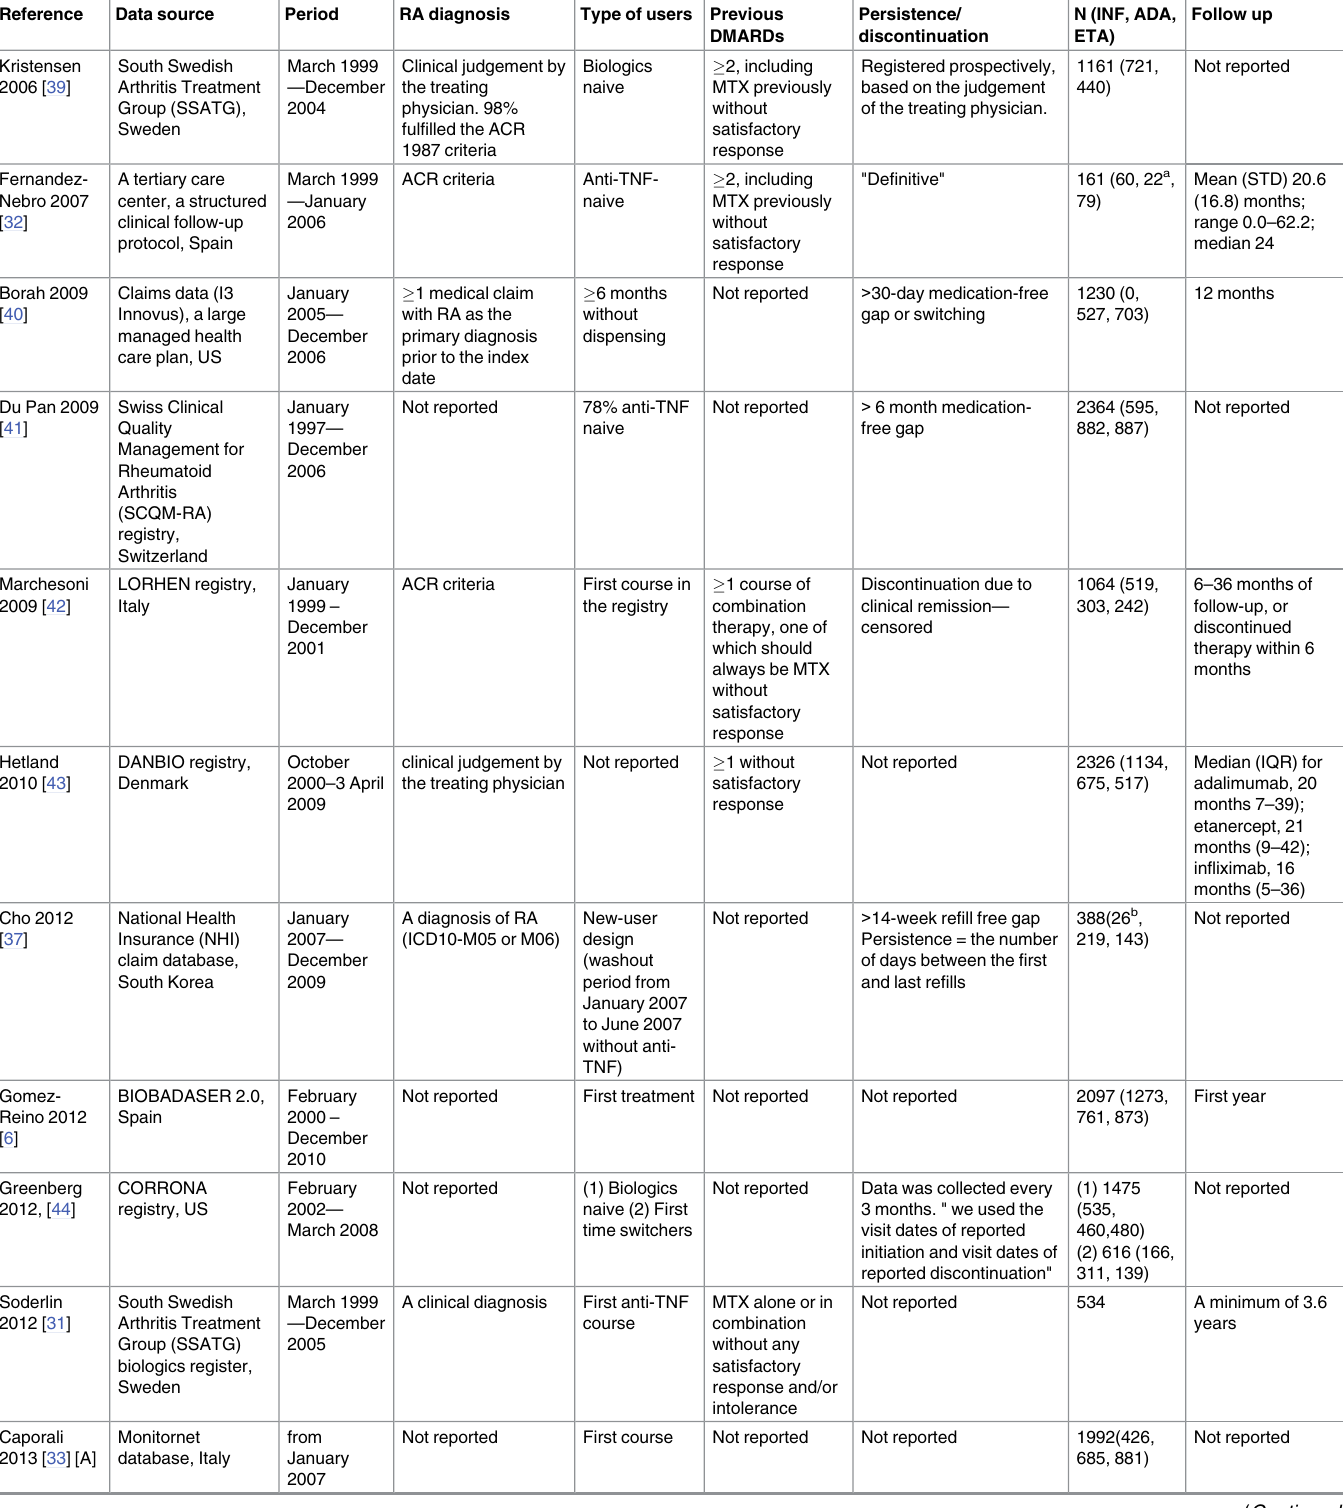
Table 1. Characteristics of eligible